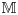
Schematics of an invasion assay system.(A) Boyden transwell invasion assay. Tumor cells were suspended in the upper chamber, while neutrophils or medium alone (control) were placed in the lower chamber. Semipermeable inserts coated with matrigel (extracellular matrix) were inserted in the filter. In response to NE secreted by N2 neutrophils in the lower chamber, tumor cells degrade the heavy extracellular matrix proteolytically and invade the lower chamber. The number of neutrophils on the lower surface of the permeable insert was counted after 22h in the absence and presence of neutrophils in the lower chamber. (B) TGF-β (G), NE (E), NE inhibitor (D), CXCL8 (C), MMP (P), TIMP (M) and tumor cells (n) can cross the semi-permeable membrane, but neither type of neutrophils (N1, N2) can cross it. Initially, the tumor cells reside in the upper chamber (domain Ω+) while neutrophils are placed in the lower chamber (domain Ω−). An extracellular matrix (ECM) layer (S) surrounds the filter, semi-permeable membrane (M).